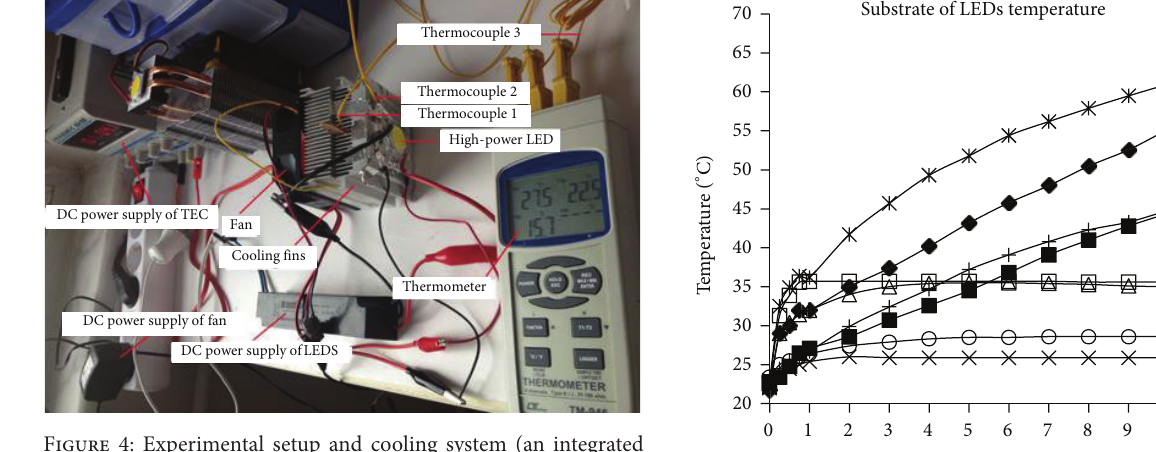
Figure 4: Experimental setup and cooling system (an integrated multifin heat sink design with a fan).